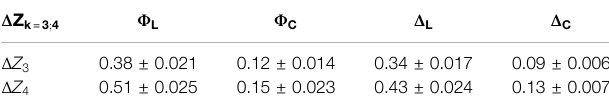
TABLE 2 | Intergroup difference of high order statistical moments characterizing embossed maps of linear and circular birefringence and dichroism in optimal phase sections of myocardial histological samples. θ * (cid:1) 0.7